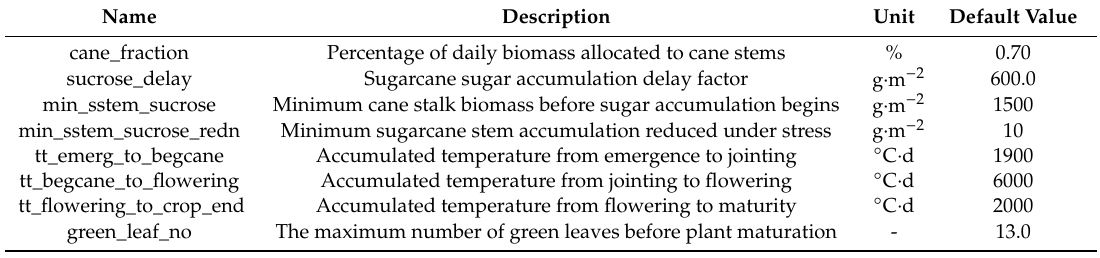
Table 7. Default values of sugarcane variety parameters for the Q138 sugarcane variety in the APSIM model.